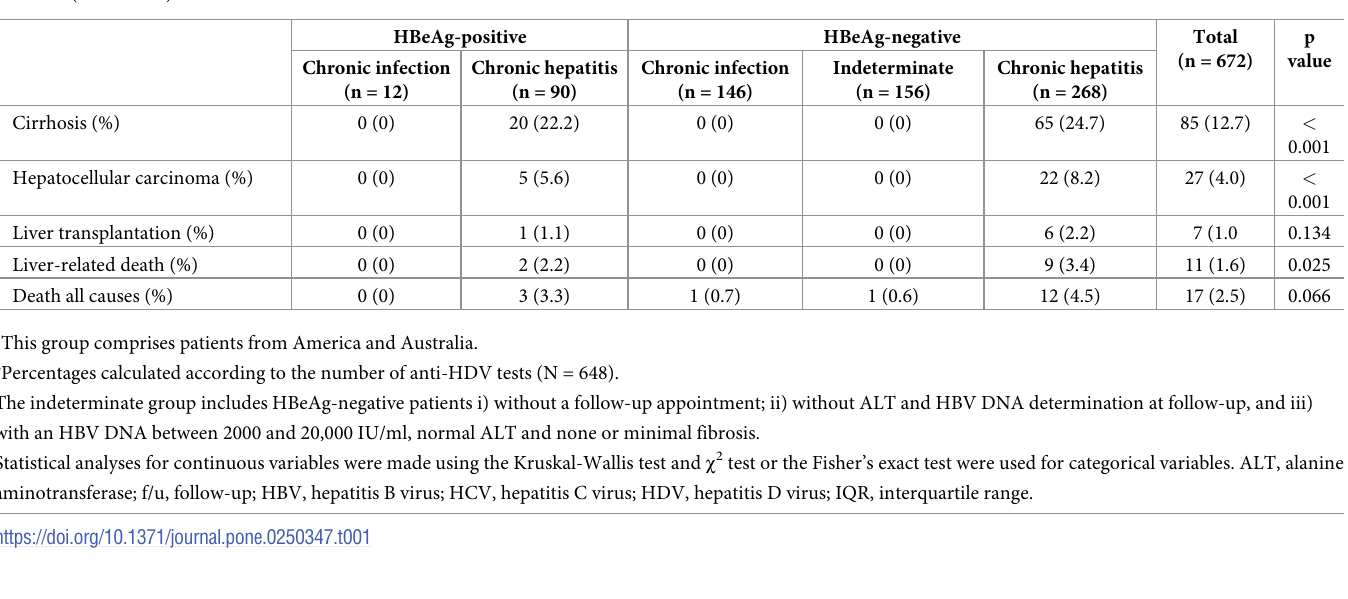
Fig). Association between liver stiffness and fibrosis stage Liver stiffness measurements were available in 474 (78.7%) patients with HBV infection alone and 32 (69.6%) patients with HDV coinfection. Liver biopsy was performed in 239 (39.7%) and 31 (67.4%) of mono- and coinfected patients, respectively. Transient elastography was per- formed within < 3 months from liver biopsy in all patients. Liver stiffness was significantly higher in HDV-positive as compared to HDV-negative patients (6.5 kPa [IQR, 5.4–8.8 kPa] vs . In patients without HDV infection, liver stiffness and histological fibrosis stage were signifi- cantly correlated (p < 0.001). However, the correlation was poor in HDV-positive patients (p = 0.203) (Fig